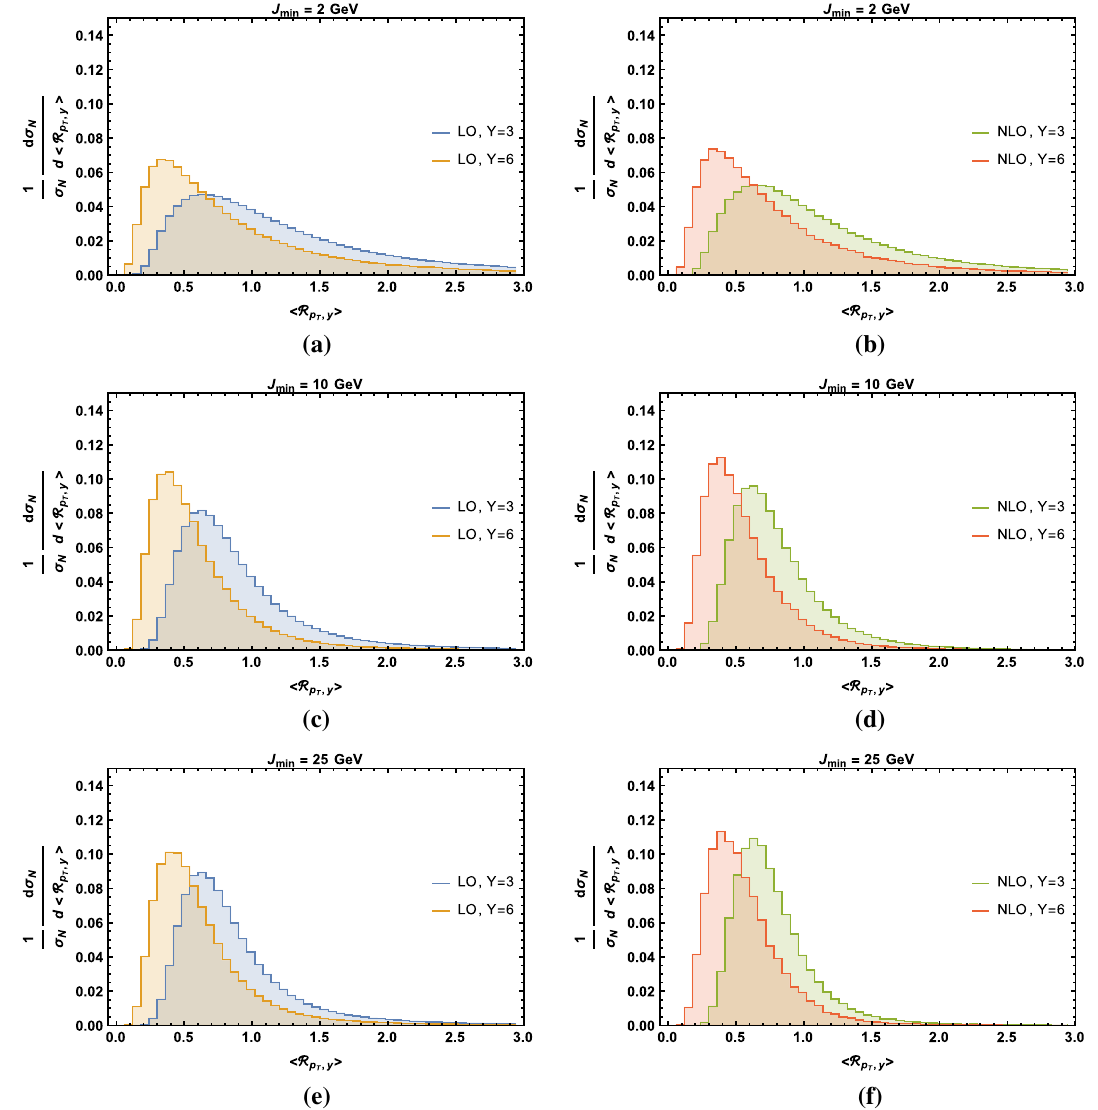
(cid:11) at LO (left) and NLO+DLs (right) for multiplicity N = 4, rapidity difference Y = 3 , 6 and J T , y